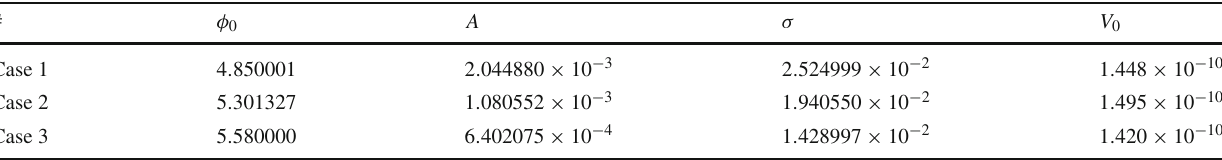
Table 1 The successful parameter sets for the potential (23) that can produce PBHs. The value of V 0 is fixed by imposing the CMB normalization at the pivot scale k ∗ = 0 . 05Mpc − 1 corresponding to N ∗ = 60